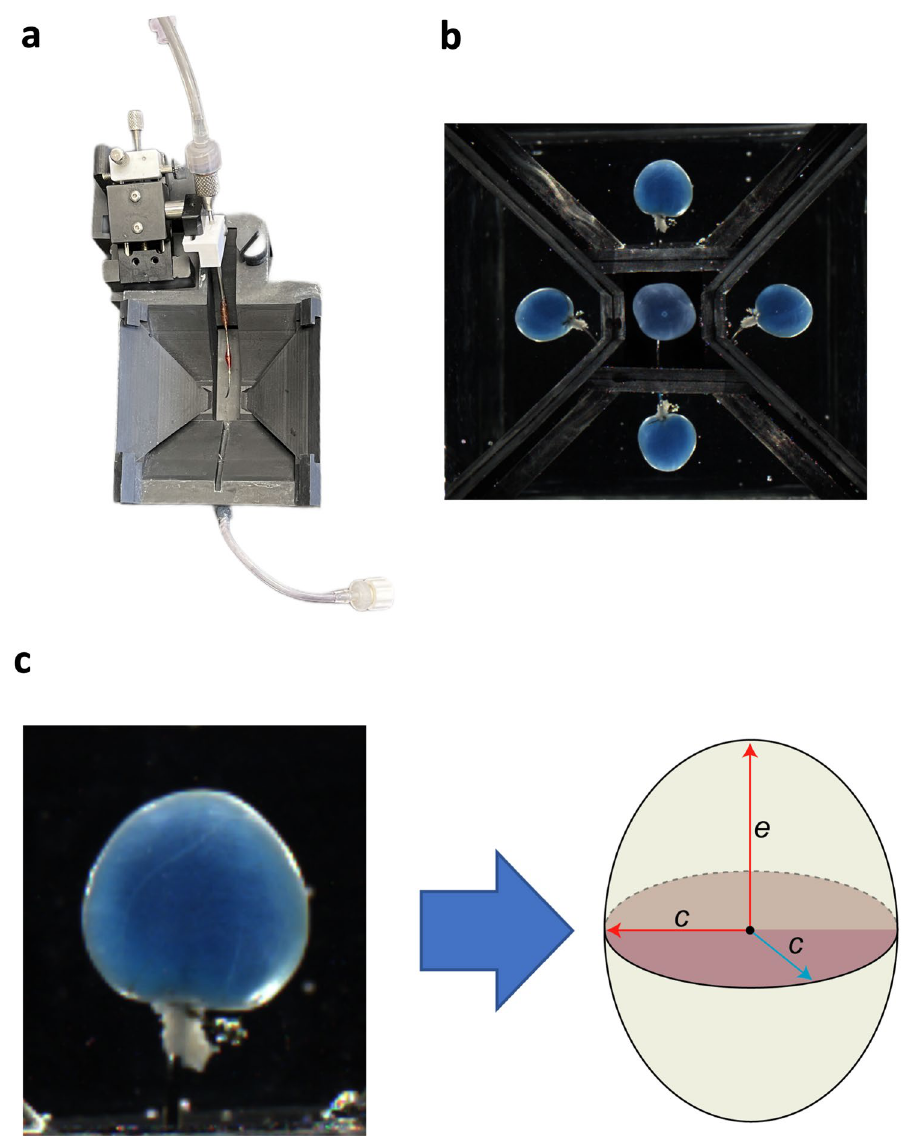
Figure 1. Pentaplanar reflected image macroscopy system. ( a ) Top view of Novel pentaplanar reflected image macroscopy (PRIM) system chamber. The mirrors were removed to make the cannula visible. ( b ) Single frame of ex vivo bladder filling video recording, showing all 5 visual planes recorded in the PRIM chamber. These images were used to calculate area and thickness of the bladder wall. ( c ) the bladder was modeled as an ellipsoid with radii c and e. This assumption was made to accurately calculate the geometrical parameters and bladder wall volume used for later determination of stress and stretch during